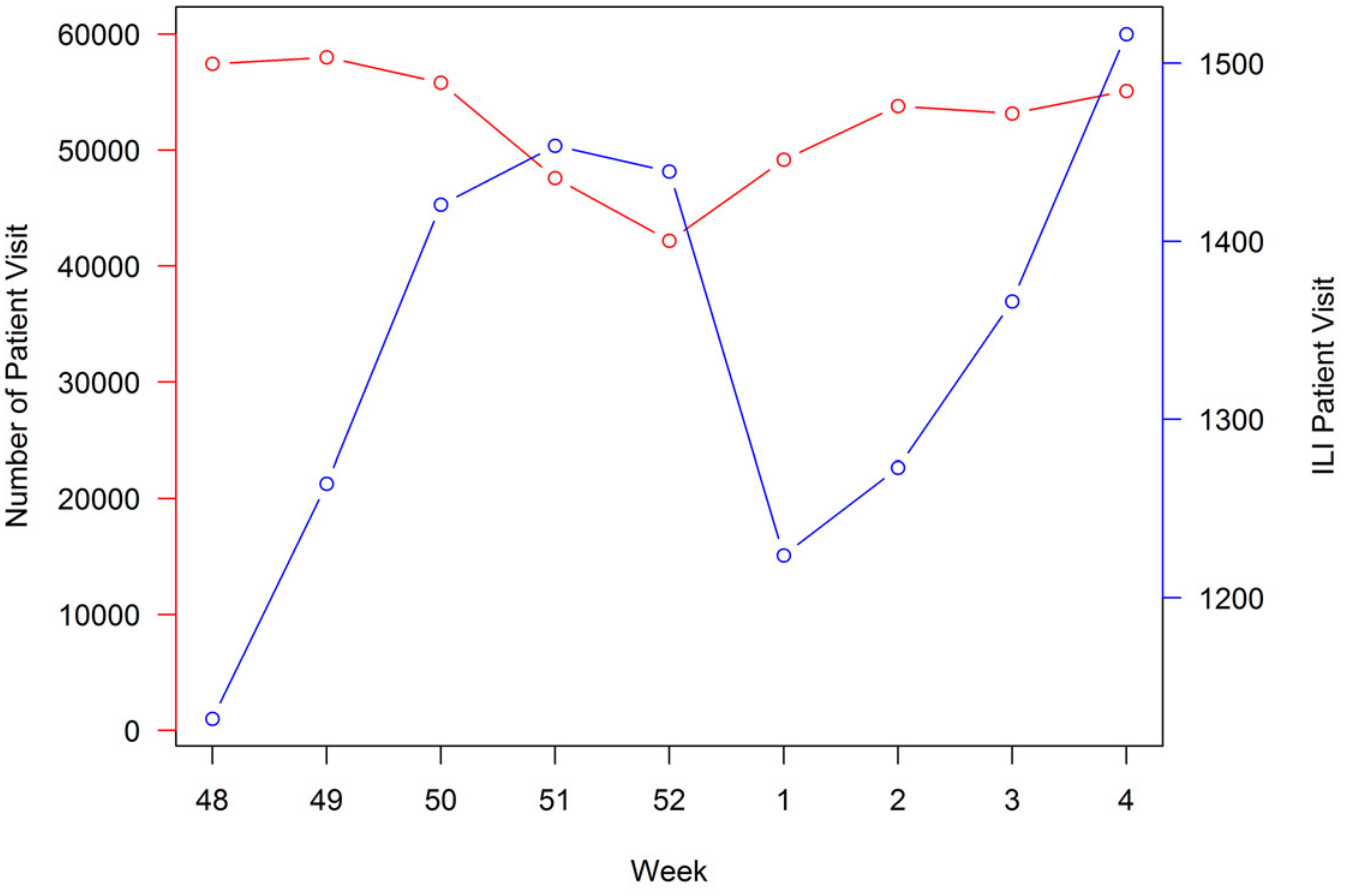
Fig 2. Average total number of patient visits (red line, scales on the left-side y-axis) and average total number of ILI visits (blue line, scales on the right-side y-axis) across all HHS regions between 2003 – 2004 and 2012 – 2013 influenza